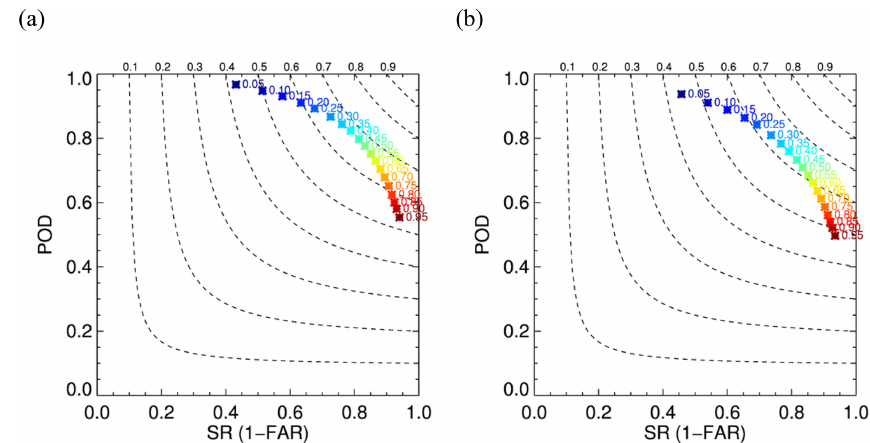
Figure 2. Performance diagrams using the two-step training approach for the (a) training and (b) testing dataset. Numbers next to the symbol are thresholds used to get corresponding SR and POD. Dashed lines represent CSI contours with labels at the top.